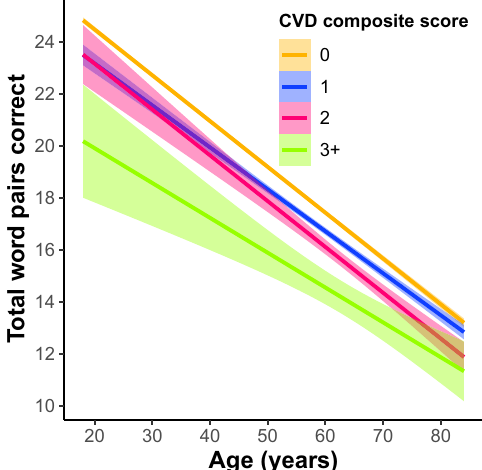
Figure 3. The main effect of a self-reported cardiovascular disease (CVD) composite score on PAL performance across 18–85 year olds. CVD composite was a sum score of self-reported heart disease, hypertension, diabetes, and stroke. Individuals were treated as groups based on their composite score (0 as the control group compared to 1, 2, and 3+). Linear regression fit (line fill ± 95% confidence interval (CI)) of the PAL total number of correct from 18 to 85 years old (F(31, 81,669) = 542.88, p = 0e+00).